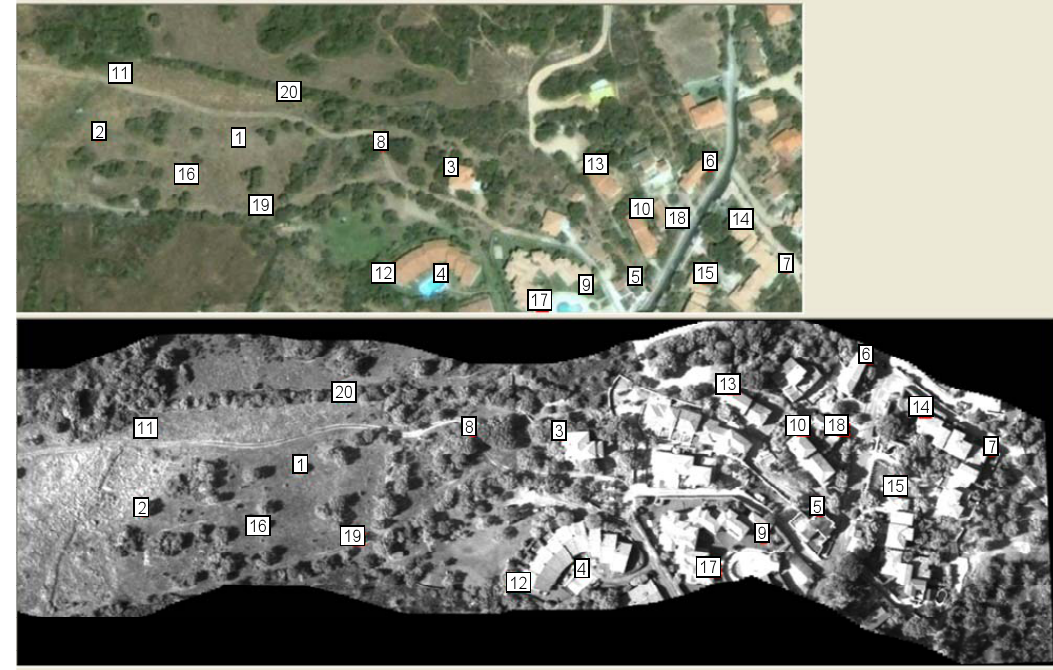
Figure 14. Map extracted from Google Earth employed for georeferencing both the mosaic and the images of the hyperspectral cube. The points employed for the geometric transformation are shown in